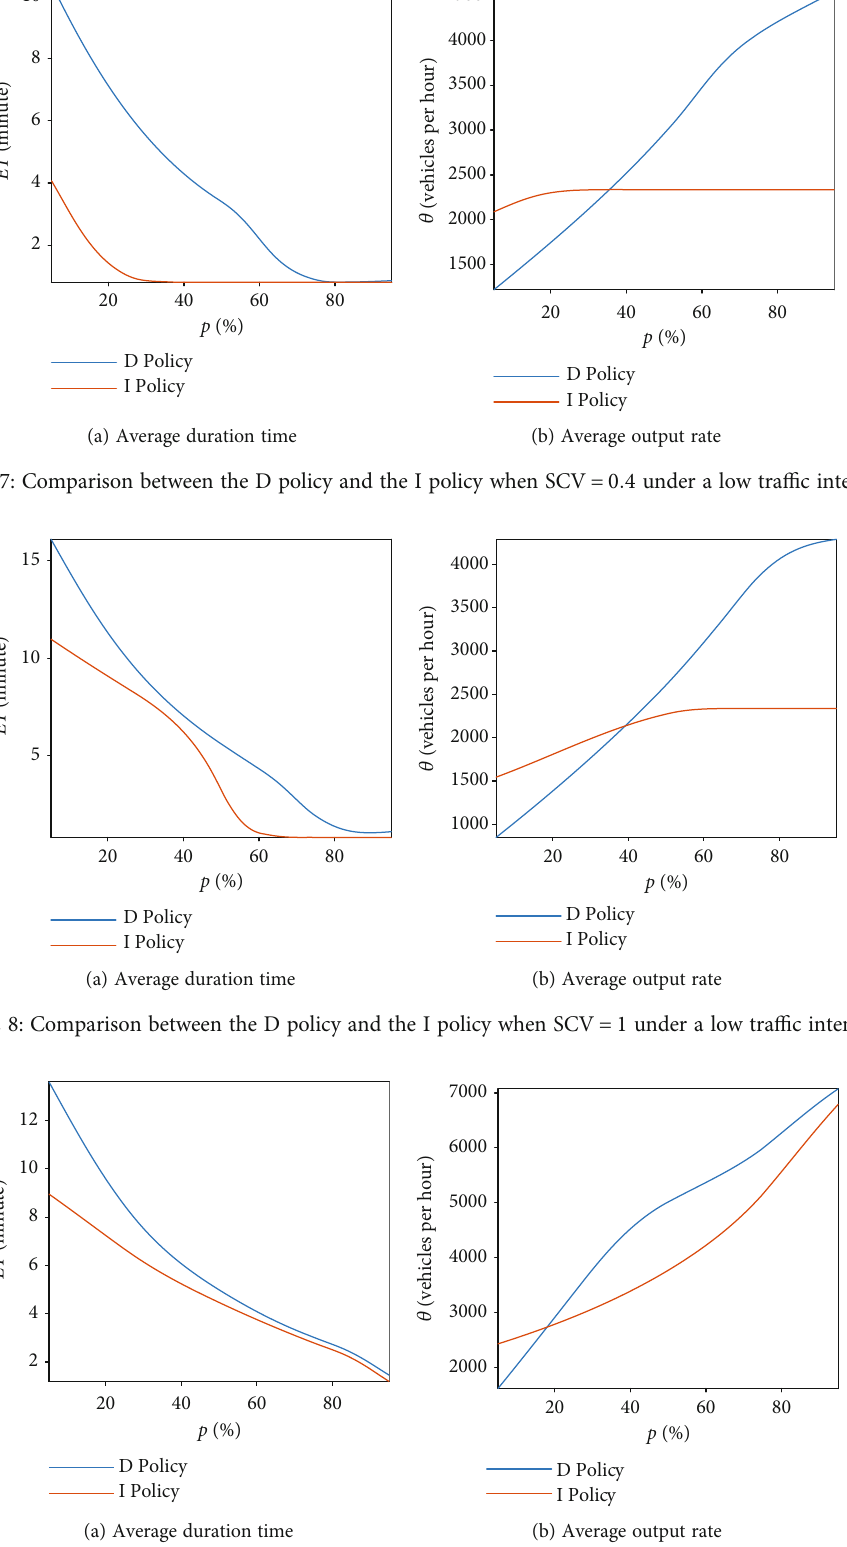
Figure 9: Comparison between the D policy and the I policy when SCV = 0 : 4 under a high tra ffi c